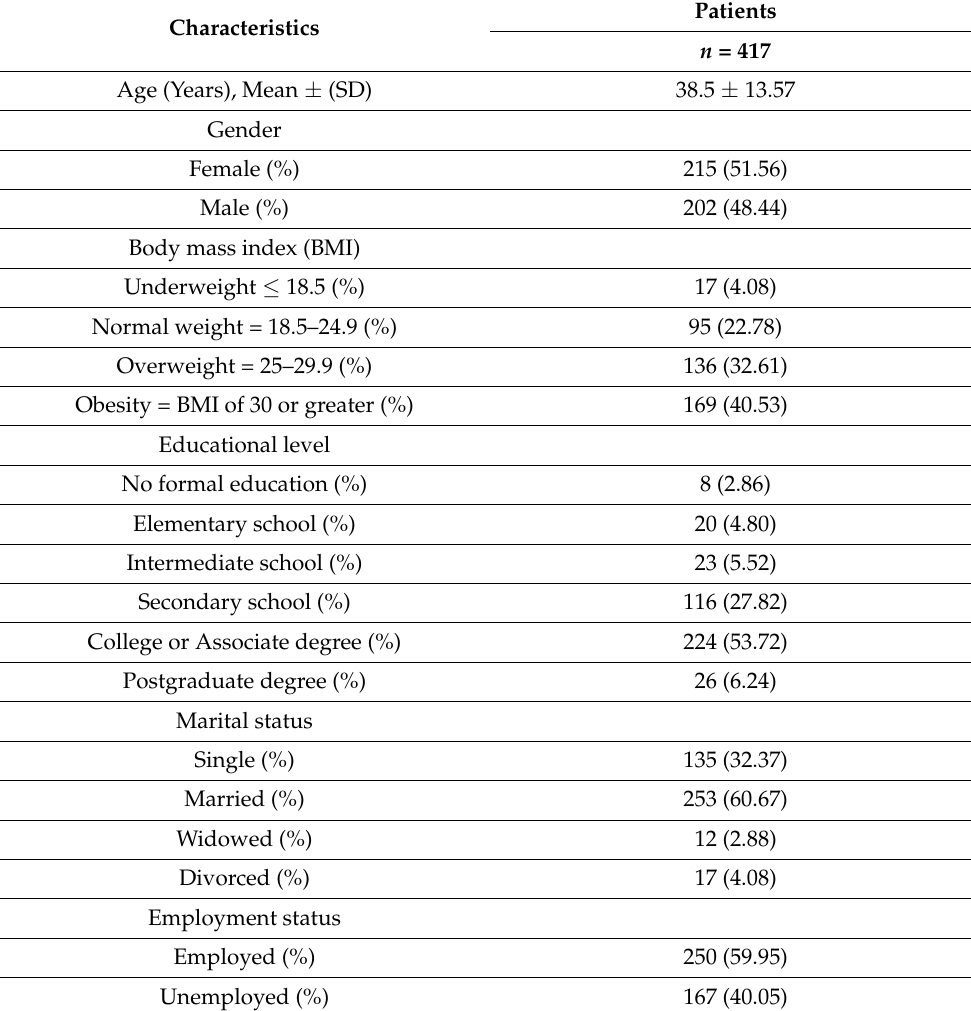
Table 1. Demographic and medical characteristics of